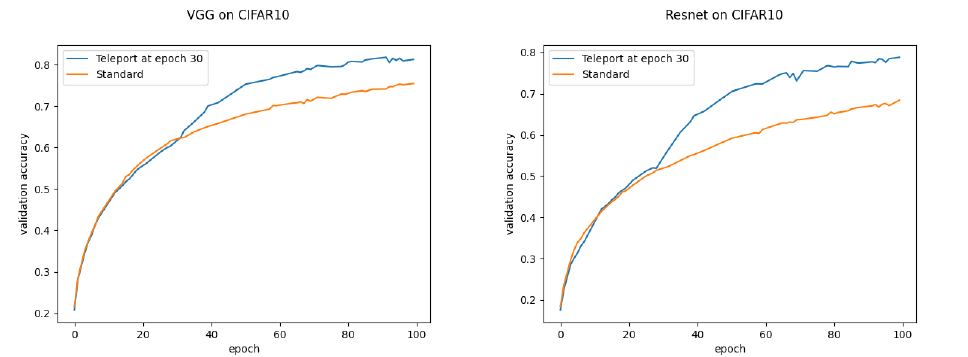
Figure 11. Validation accuracy for VGG ( left ) and ResNet ( right ). We plot two curves for each model, the orange curves are the usual SGD training and the blue curves are SGD with one teleportation at epoch 30.